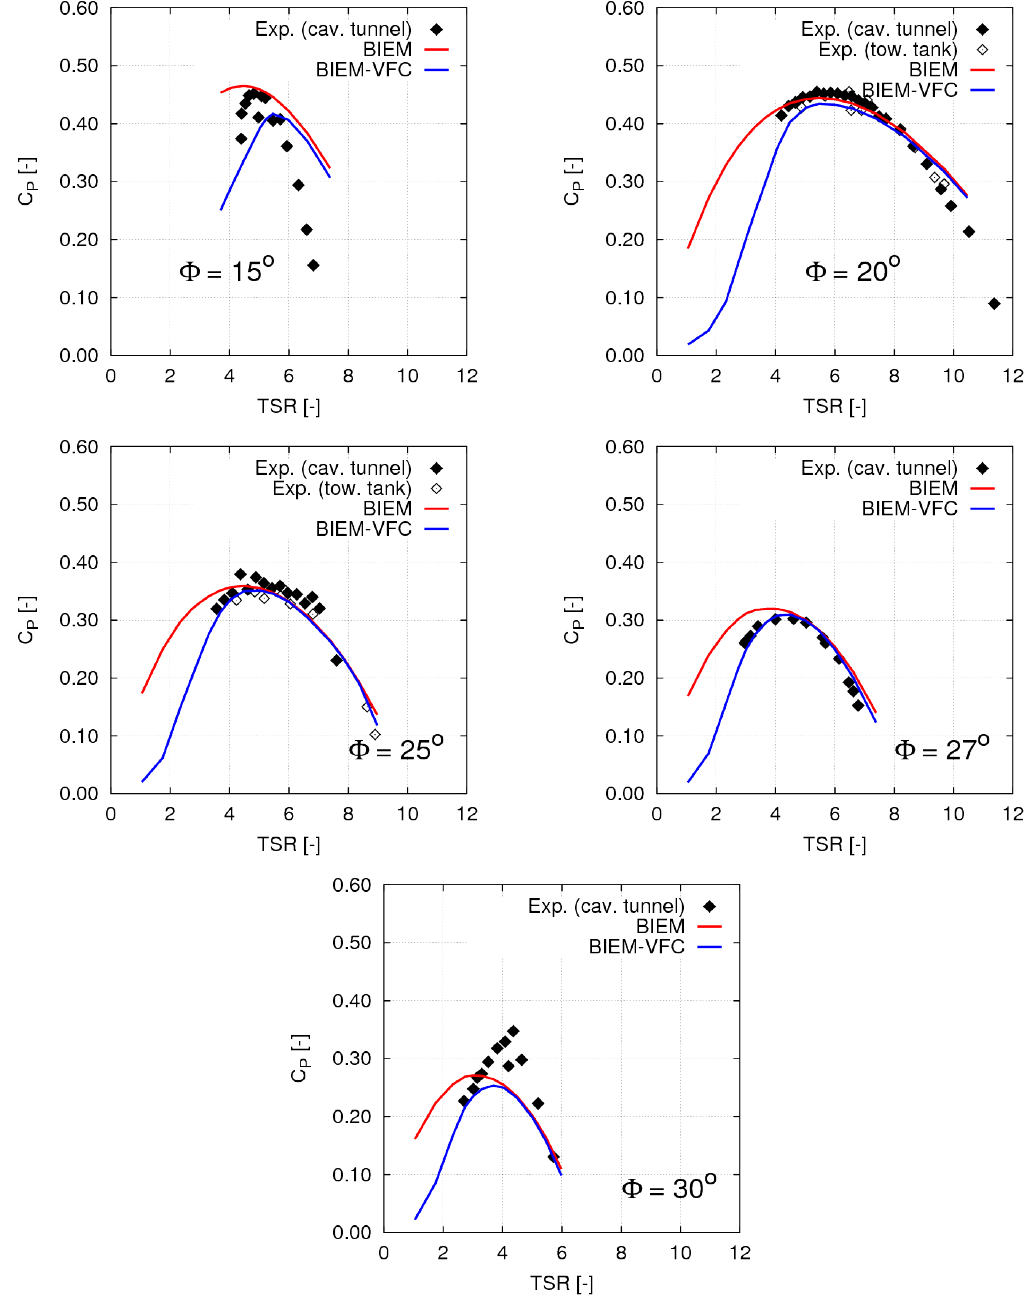
Figure 26. UoS-VP turbine performance predictions by BIEM and BIEM-VFC compared to experimental data in [13]. Power coefficient at pitch settings Φ = 15 ◦ ,20 ◦ ,25 ◦ ,27 ◦ ,30 ◦